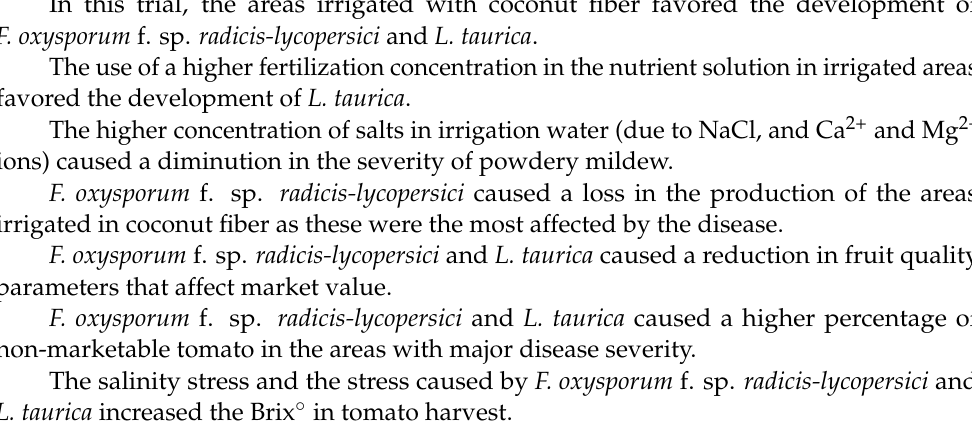
Powdery mildew in different moment of the trial. Table S3: Percentage of no marketable yield in harvest moments. Figure S1: Comparison of the total marketable yield means and 95 percent LSD differences for Coconut Substrate treatment (TH) grouping all the treatments and Soil treatment (TS) grouping all the treatments. Figure S2: Comparison of the Fruit weight (a) and diameter (b) means and 95 percent LSD differences for Coconut Substrate treatment (TH) and Soil treatment